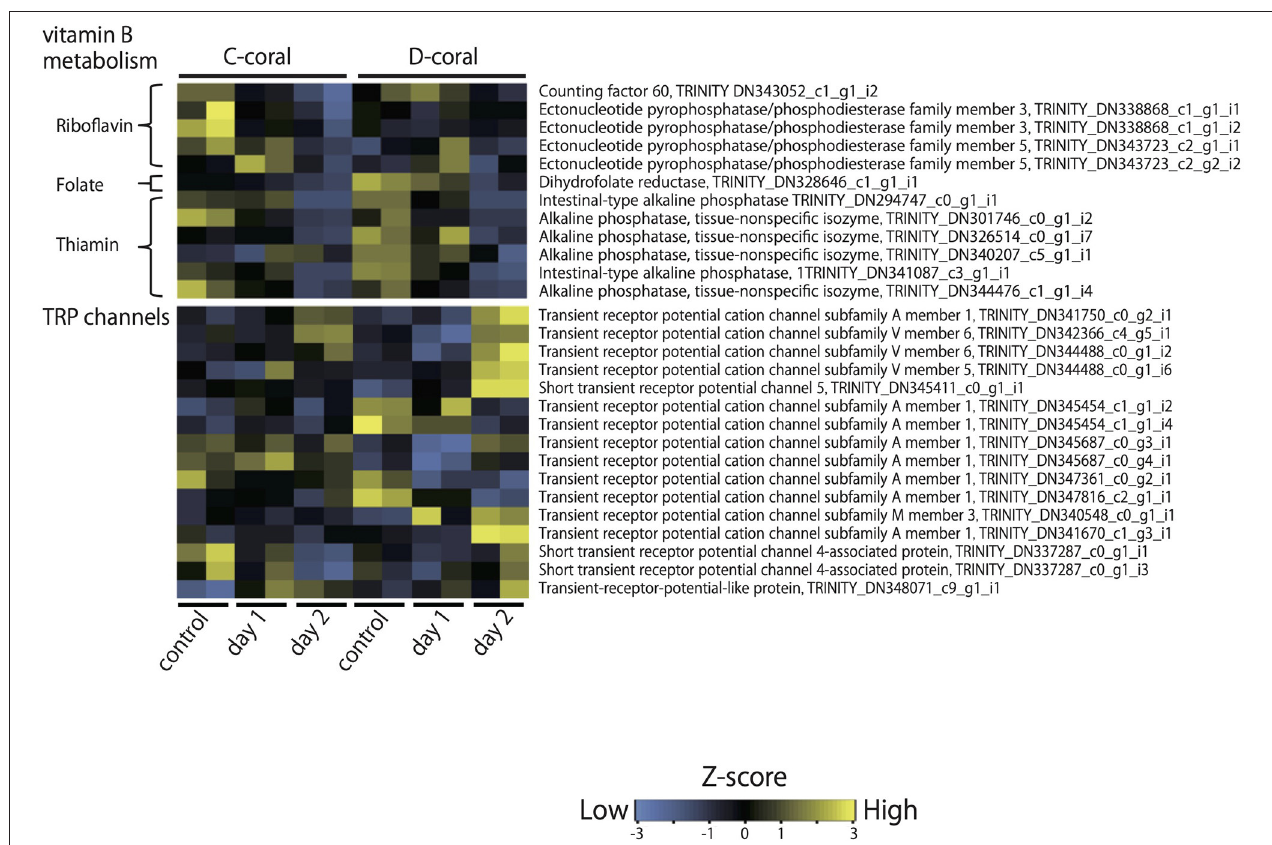
FIGURE 4 | Heatmap displaying the relative expression values ( z -score of TMM-normalized FPKM values) of contigs, which shows the different expression patterns of C- and D-corals during treatment with high temperature and strong light. As representative examples, the expression patterns of contigs encoding TRP channels and genes involved in vitamin B metabolism are shown. Expression values were converted into z-scores and plotted by heatmap.2 in